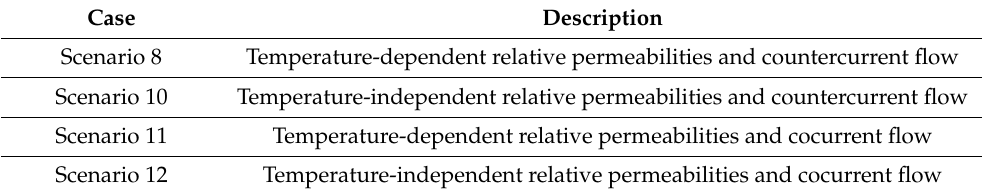
Table 5. Scenarios of temperature-dependent relative permeabilities and countercurrent flow.